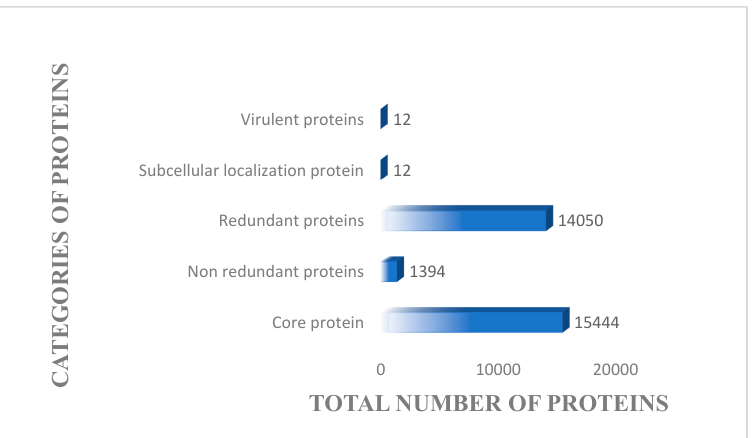
Figure 4. The total number of core proteins, sub-cellular localized proteins, redundant, non-redundant proteins and virulent proteins. The proteins obtained at each step were screened from core proteome of 11 strains of S. auricularis.